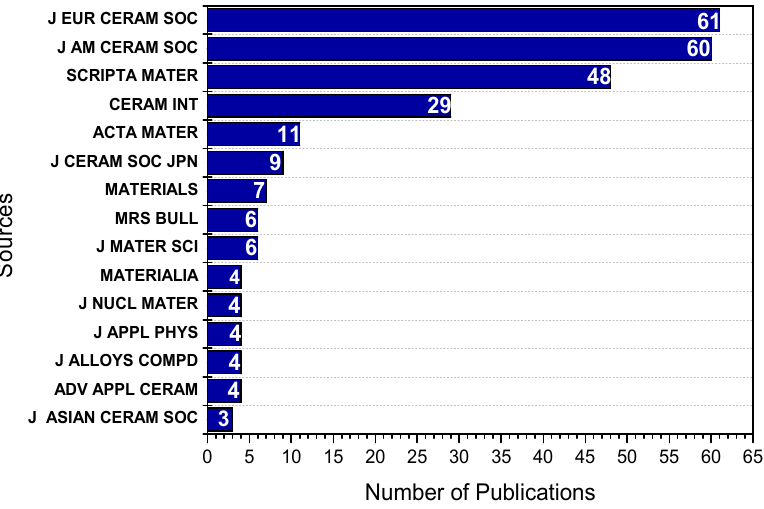
Figure 2. Top 15 sources with 3 or more published